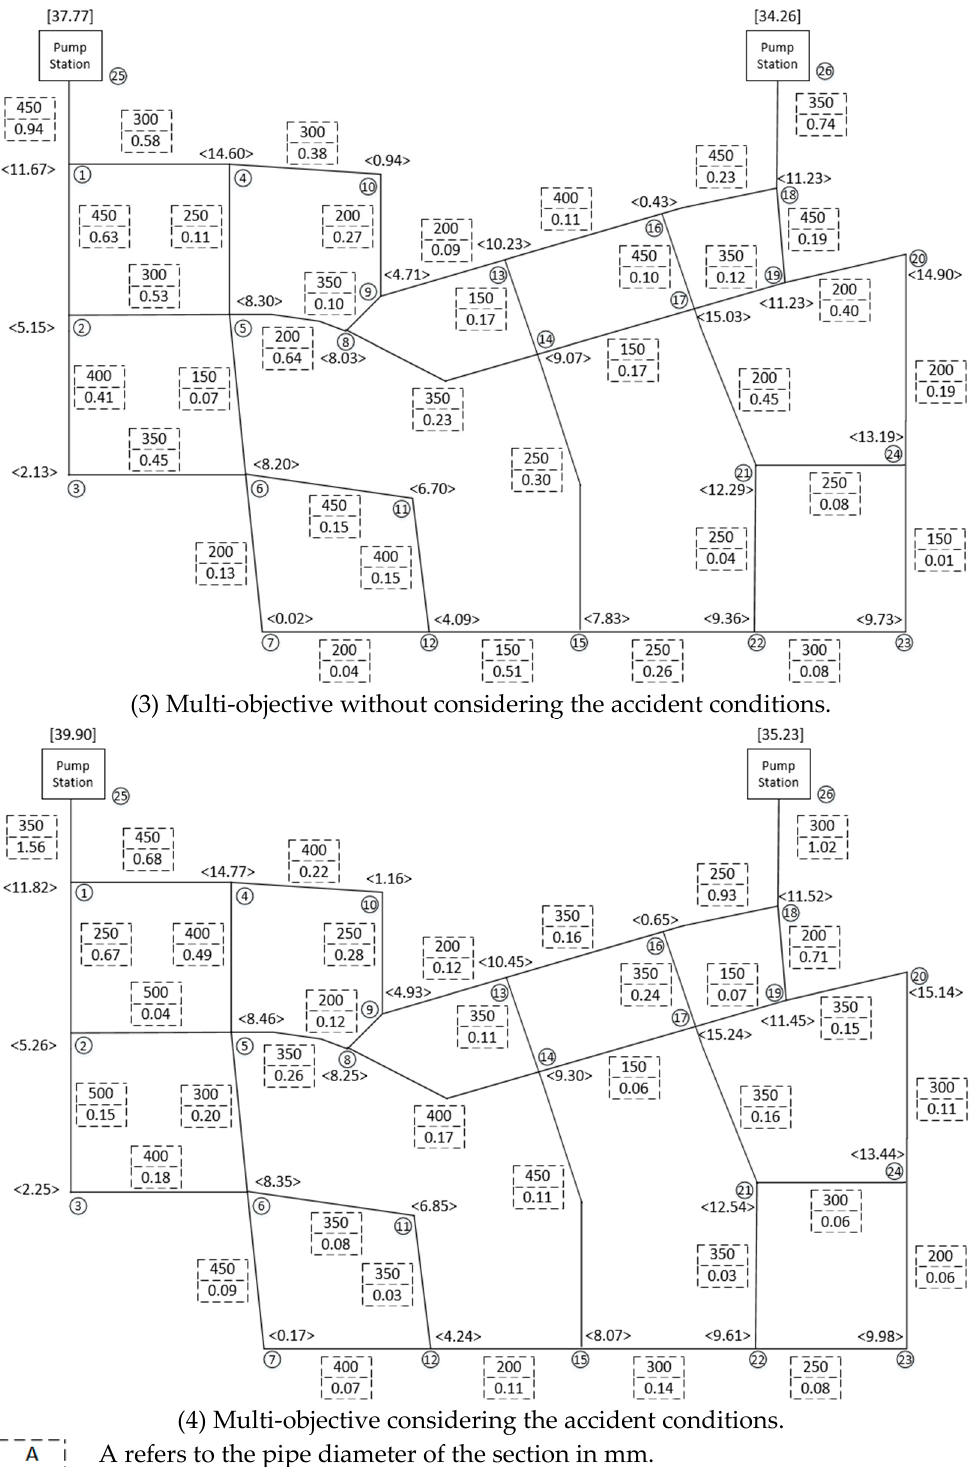
Figure 10. Optimization results of a multi pump station water distribution network.